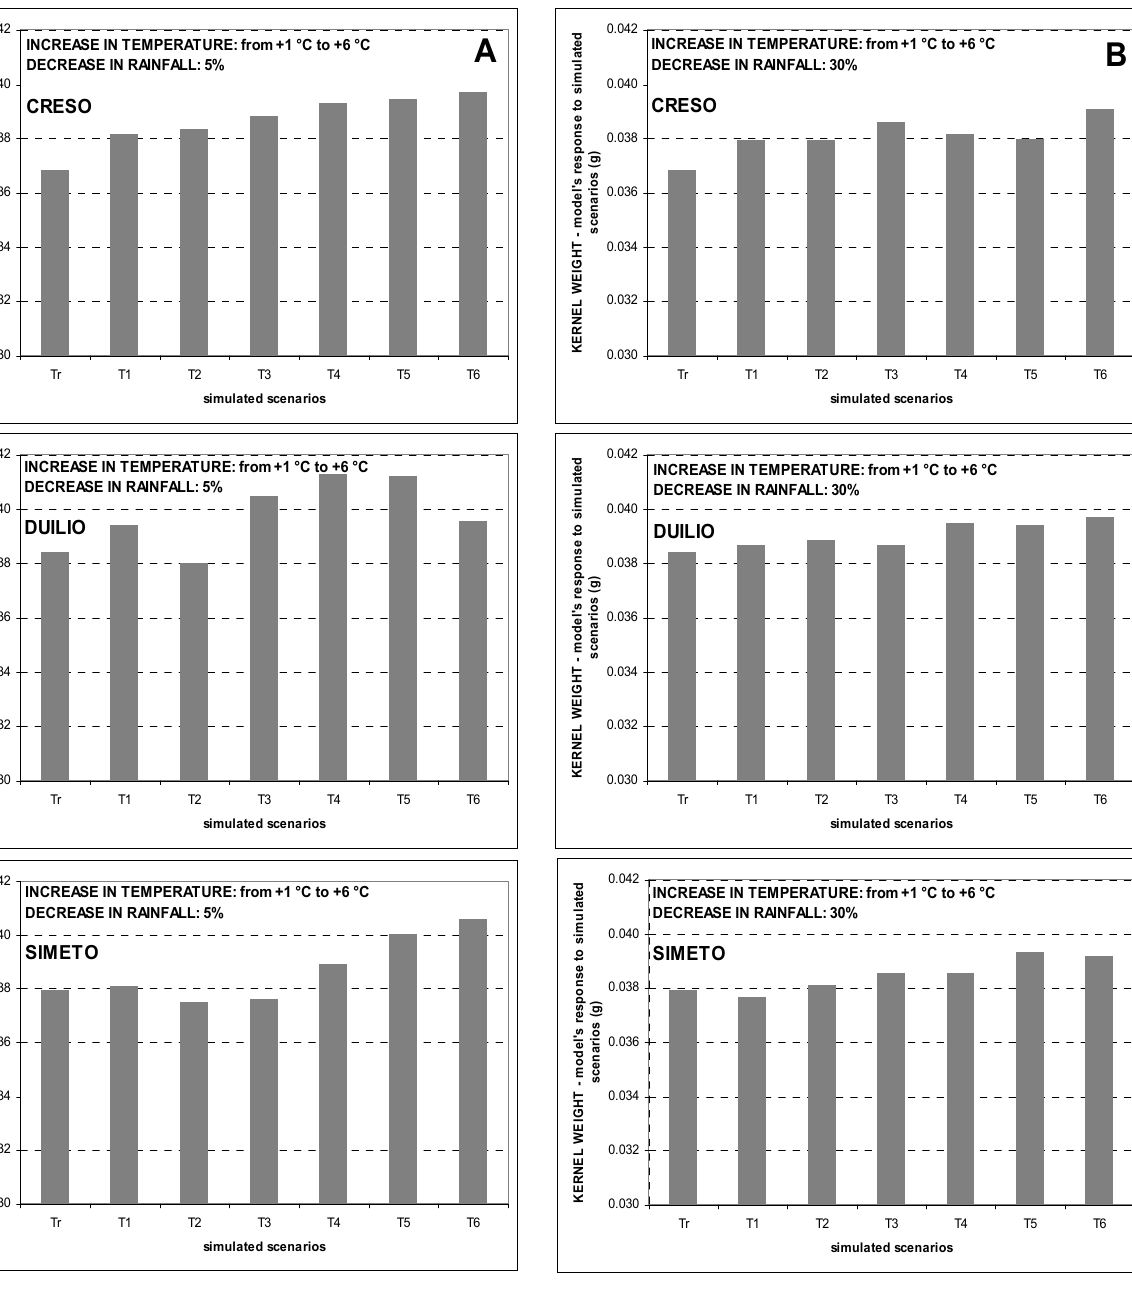
Figure 7. Average seed weight trends over the period 1989–2004 at the experimental site of Ussana for climate change scenarios characterized by increasing temperature (from +1 °C to +6 °C) and rainfall reduction by 5% ( A ) and 30% ( B ). Tr = observed data.